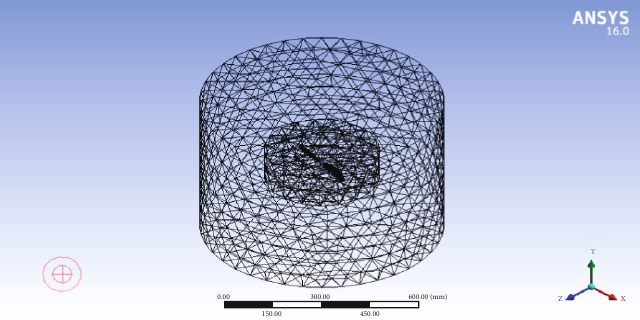
Figure 16: Design-3 (generated mesh). Mesh type: unstructured tetrahedral mesh. Nodes: 120561. Elements: 81184.